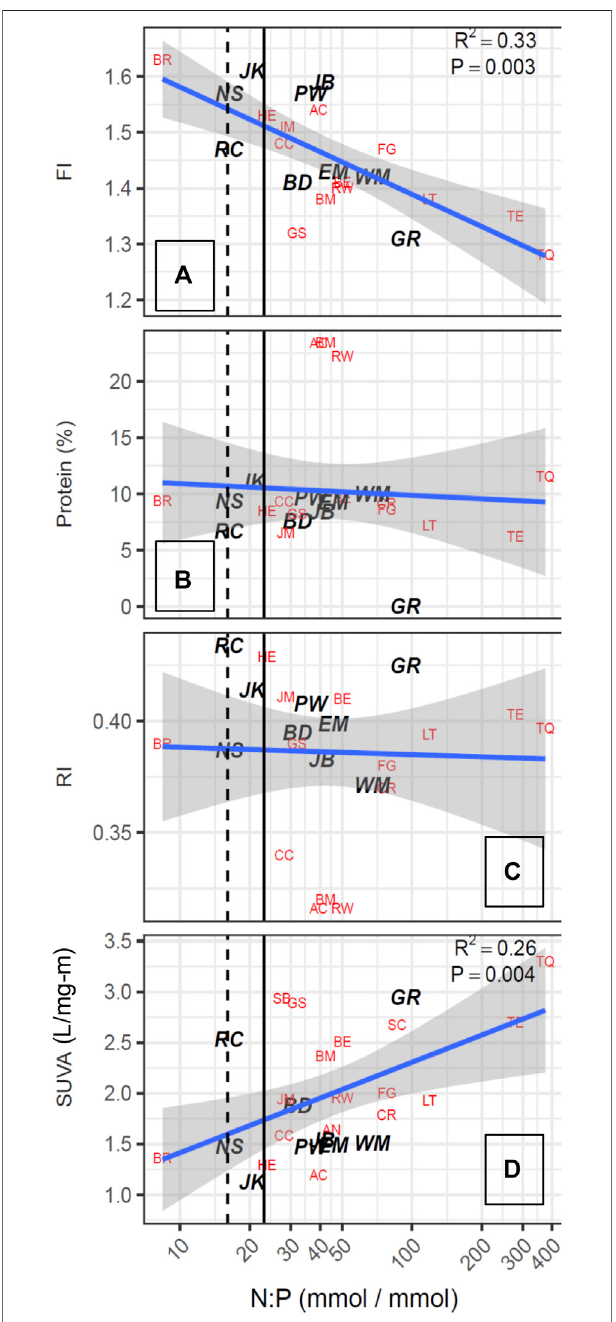
FIGURE 7 | DOM quality metrics plotted as a function of atomic N:P ratios. Dashed line indicates 16:1 (Red fi eld ratio), solid line indicates 23:1. N:P ratios > 23:1 are considered P